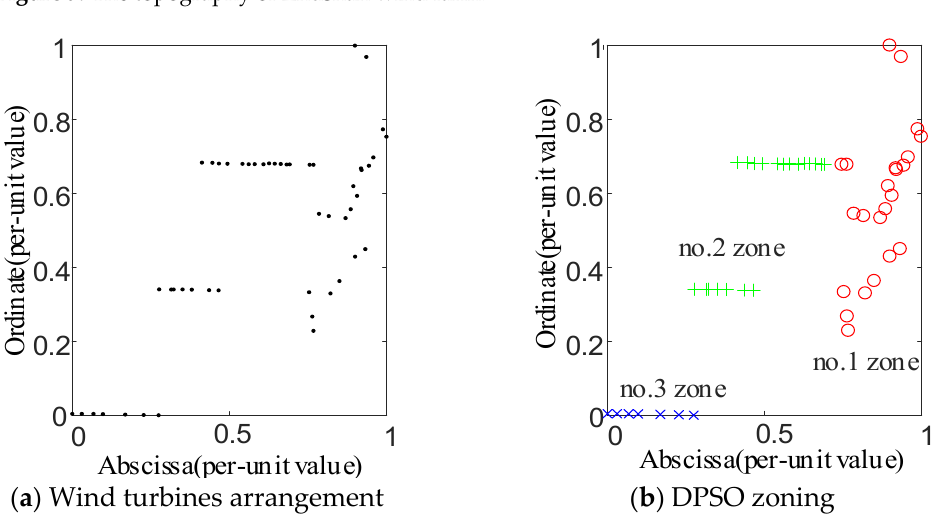
Figure 9. The topography of Zhushan wind farm.